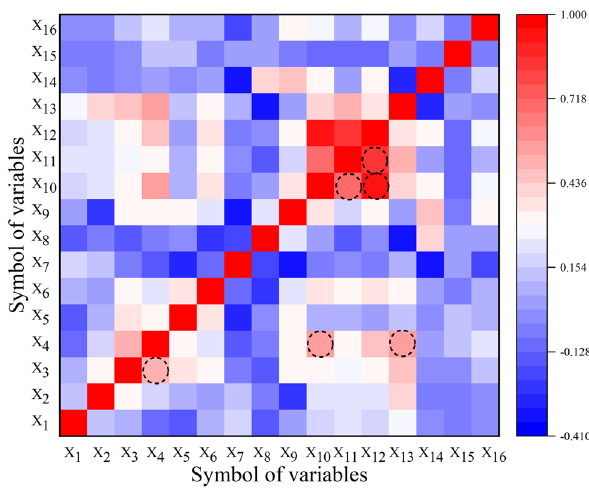
Figure 4: Heatmap of Pearson correlation coe ffi cient between variables.